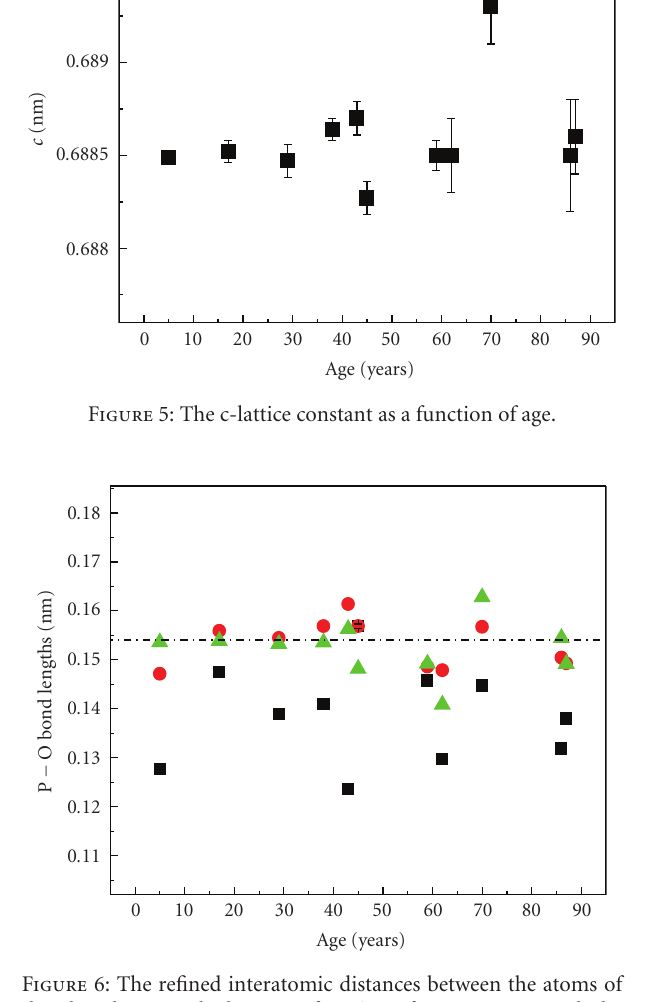
Figure 6: The refined interatomic distances between the atoms of the phosphate tetrahedron as a function of age. Squares mark the P-O1, triangles the P-O2 and circles the P-O3 bond lengths. Error bars are plotted for the P-O1 (not shown in this scale).